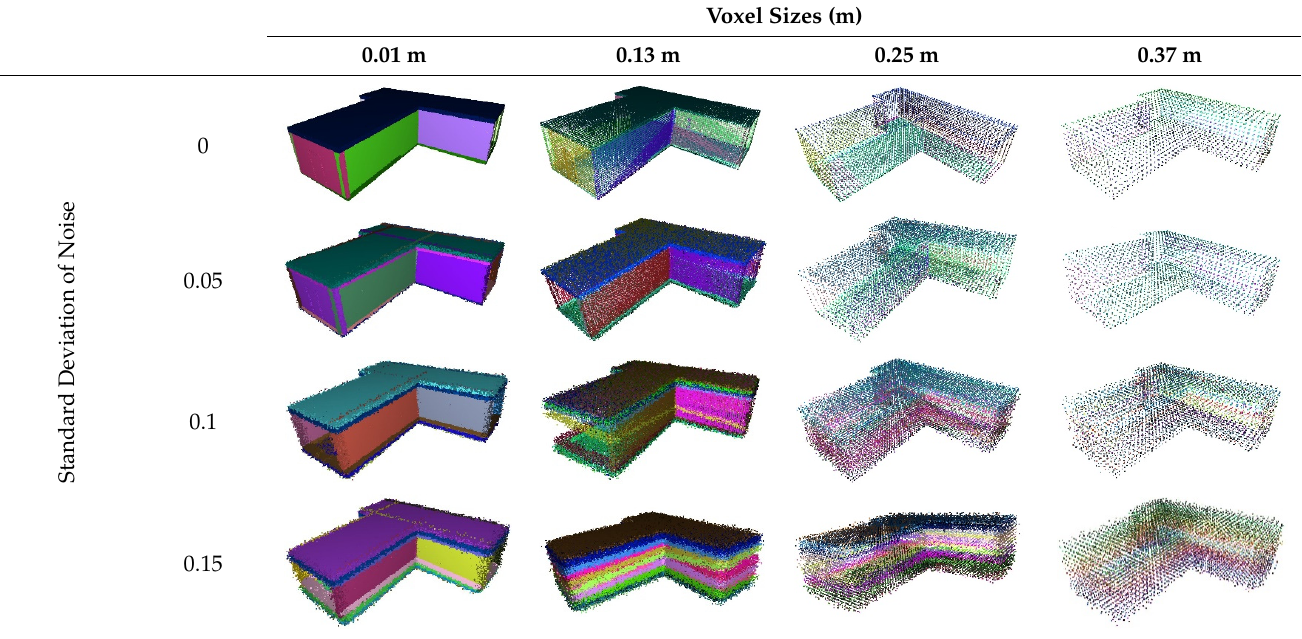
Table 4. Segmented as-built point cloud with different noise levels and voxel sizes.